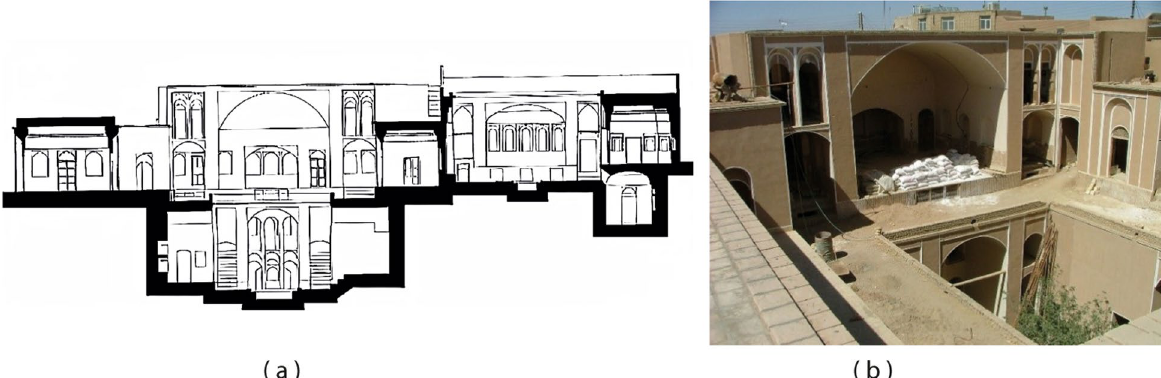
Fig. 7 Godal‑baghcheh in the Olumiha house, Yazd: ( a ) a cross‑sectional elevation view (Source: Haji‑Qassemi and Khoei 2004) and ( b ) a view in the large courtyard (Source: the